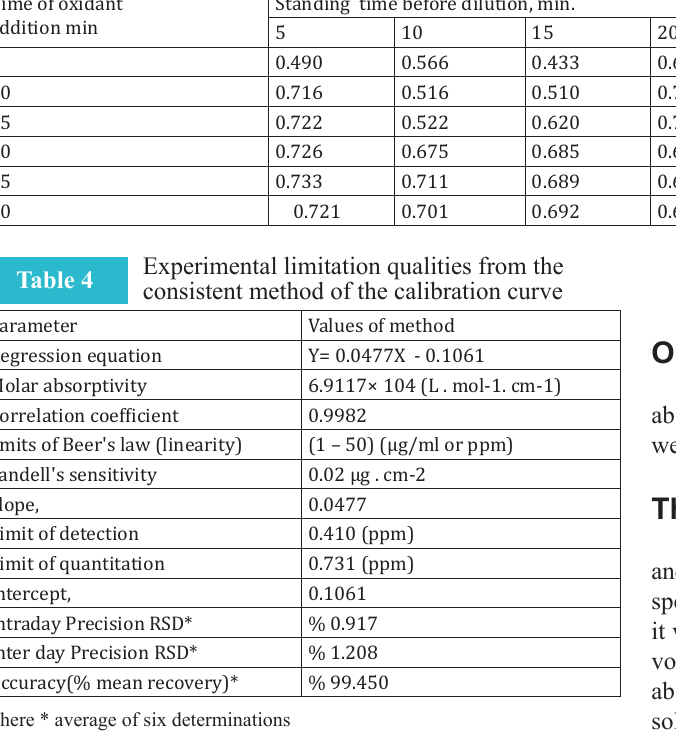
Standing time before dilution, min.